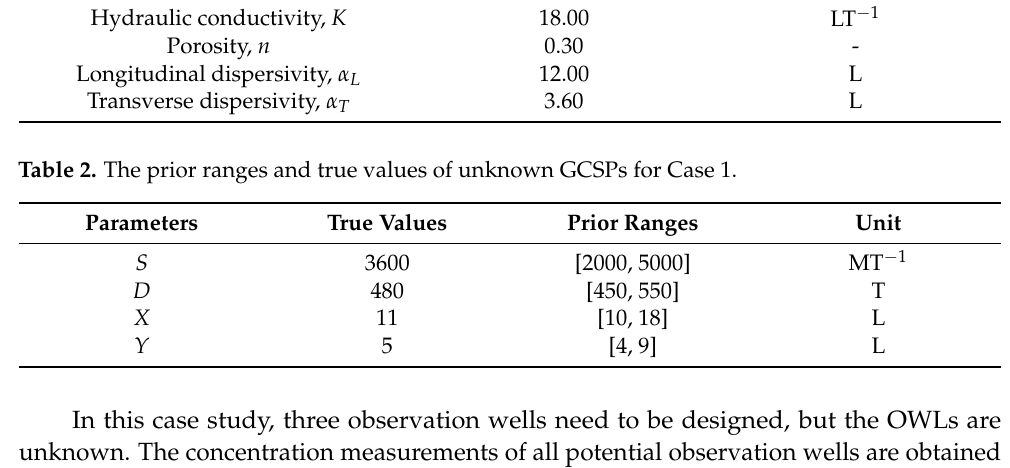
Figure 2. MLP approach structure diagram.